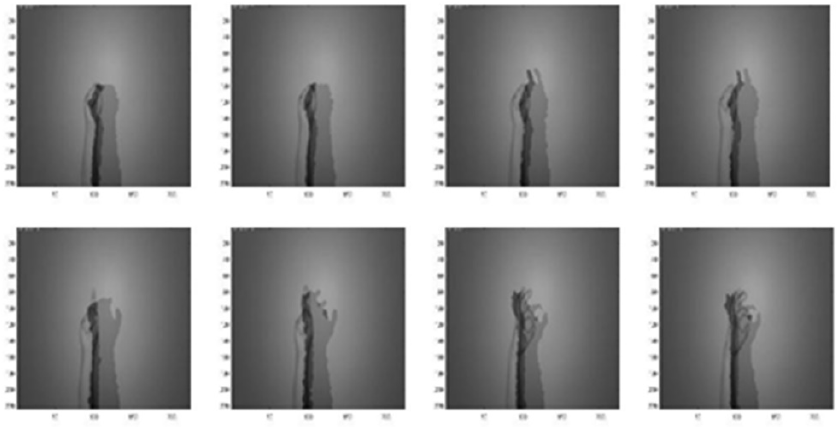
Figure 18. The fused image of two different sensor modalities of “Depth-Grayscale” and “CCD RGB-IR” by wavelet image fusion with mean-mean operations for VGG-16 CNN deep learning and recognition (e.g., the hand gesture intention action, Action 1).